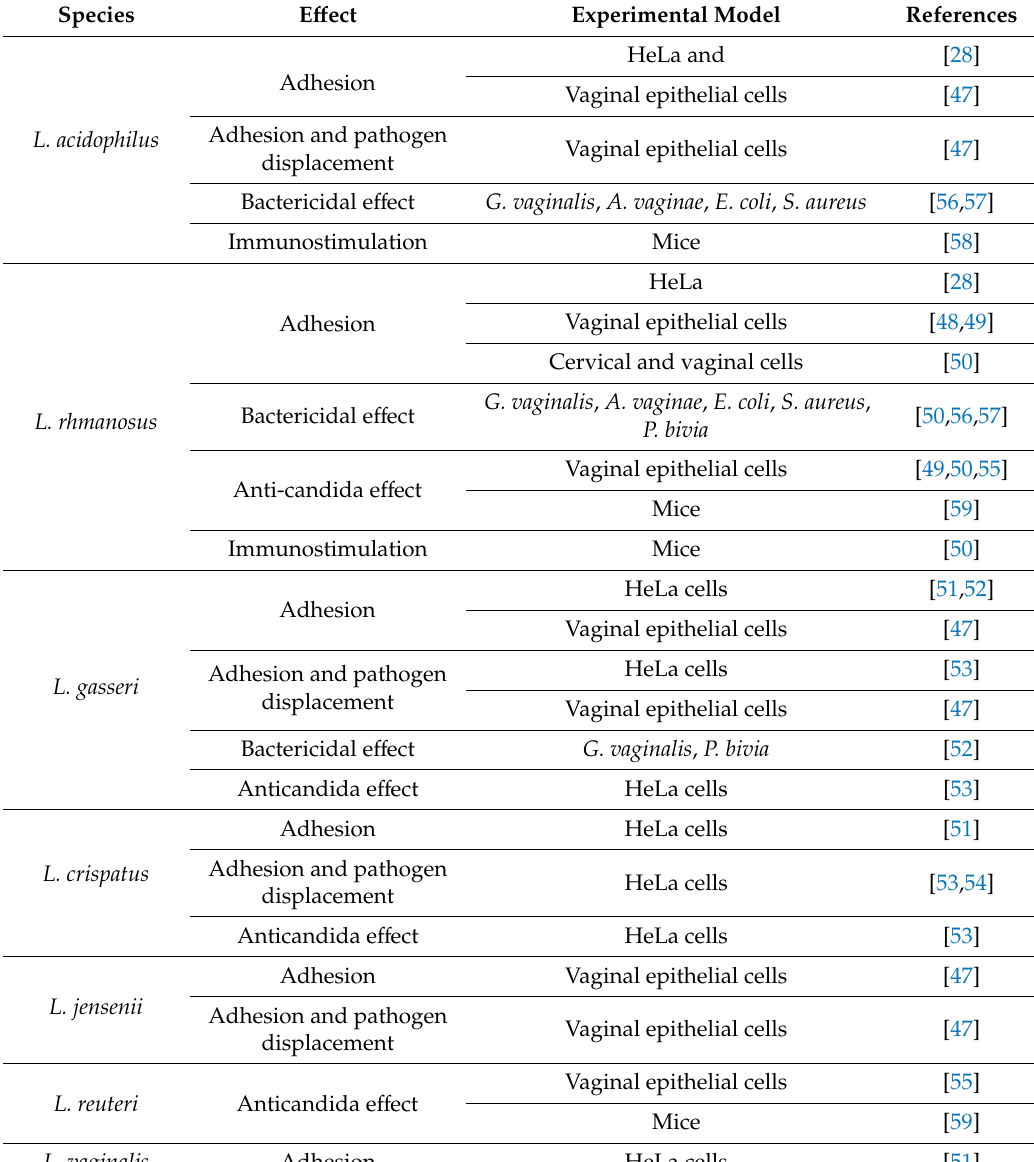
Table 2. E ff ects of Lactobacilli: Preclinical